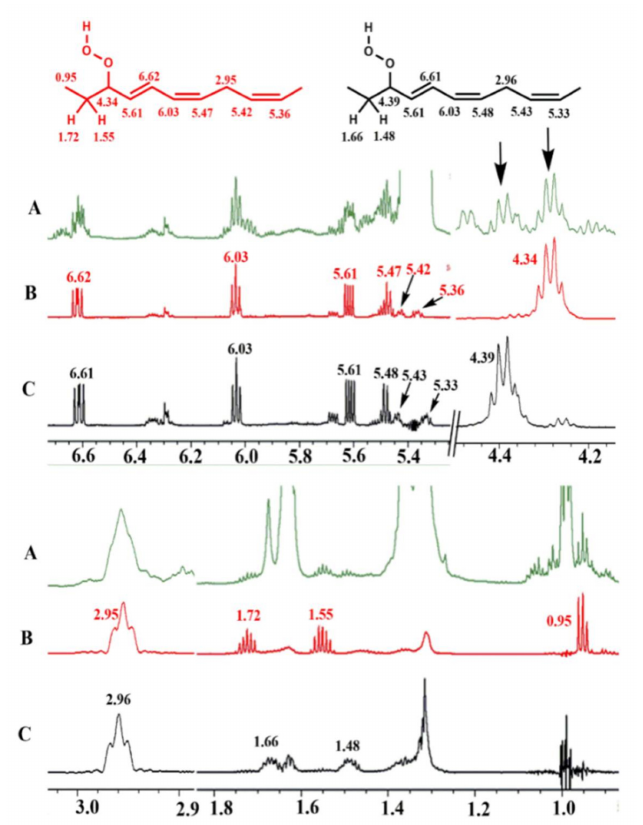
Figure 46. ( A ) 800 MHz 1D 1 H-NMR spectrum of 20 mg methyl linolenate, subjected to heating at 40 ◦ C for 48 h, in CDCl 3 (acquisition time = 1.02 s, relaxation delay = 5 s, number of scans = 128, experimental time = 10 min), T = 298 K. ( B , C ) selective 1D-TOCSY spectra of the same solution using a mixing time of τ m = 300 ms. The arrows denote the selected resonances that were excited at δ 4.34 ( B ) of the cis , cis , trans -16-OOH hydroperoxide and δ 4.39 ( C ) of the trans , cis , cis -9-OOH hydroperoxide. Number of scans = 256, experimental time = 20 min